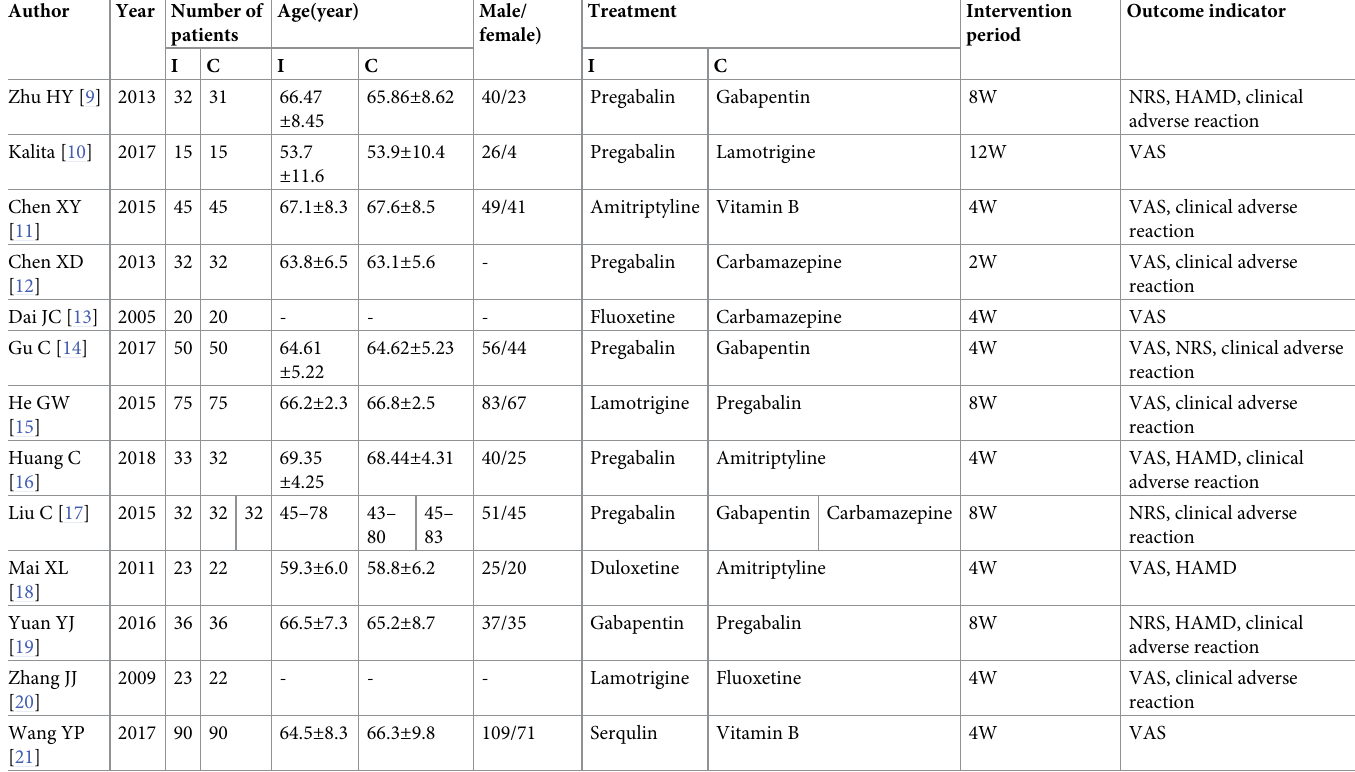
Table 1. Basic characteristics of the included